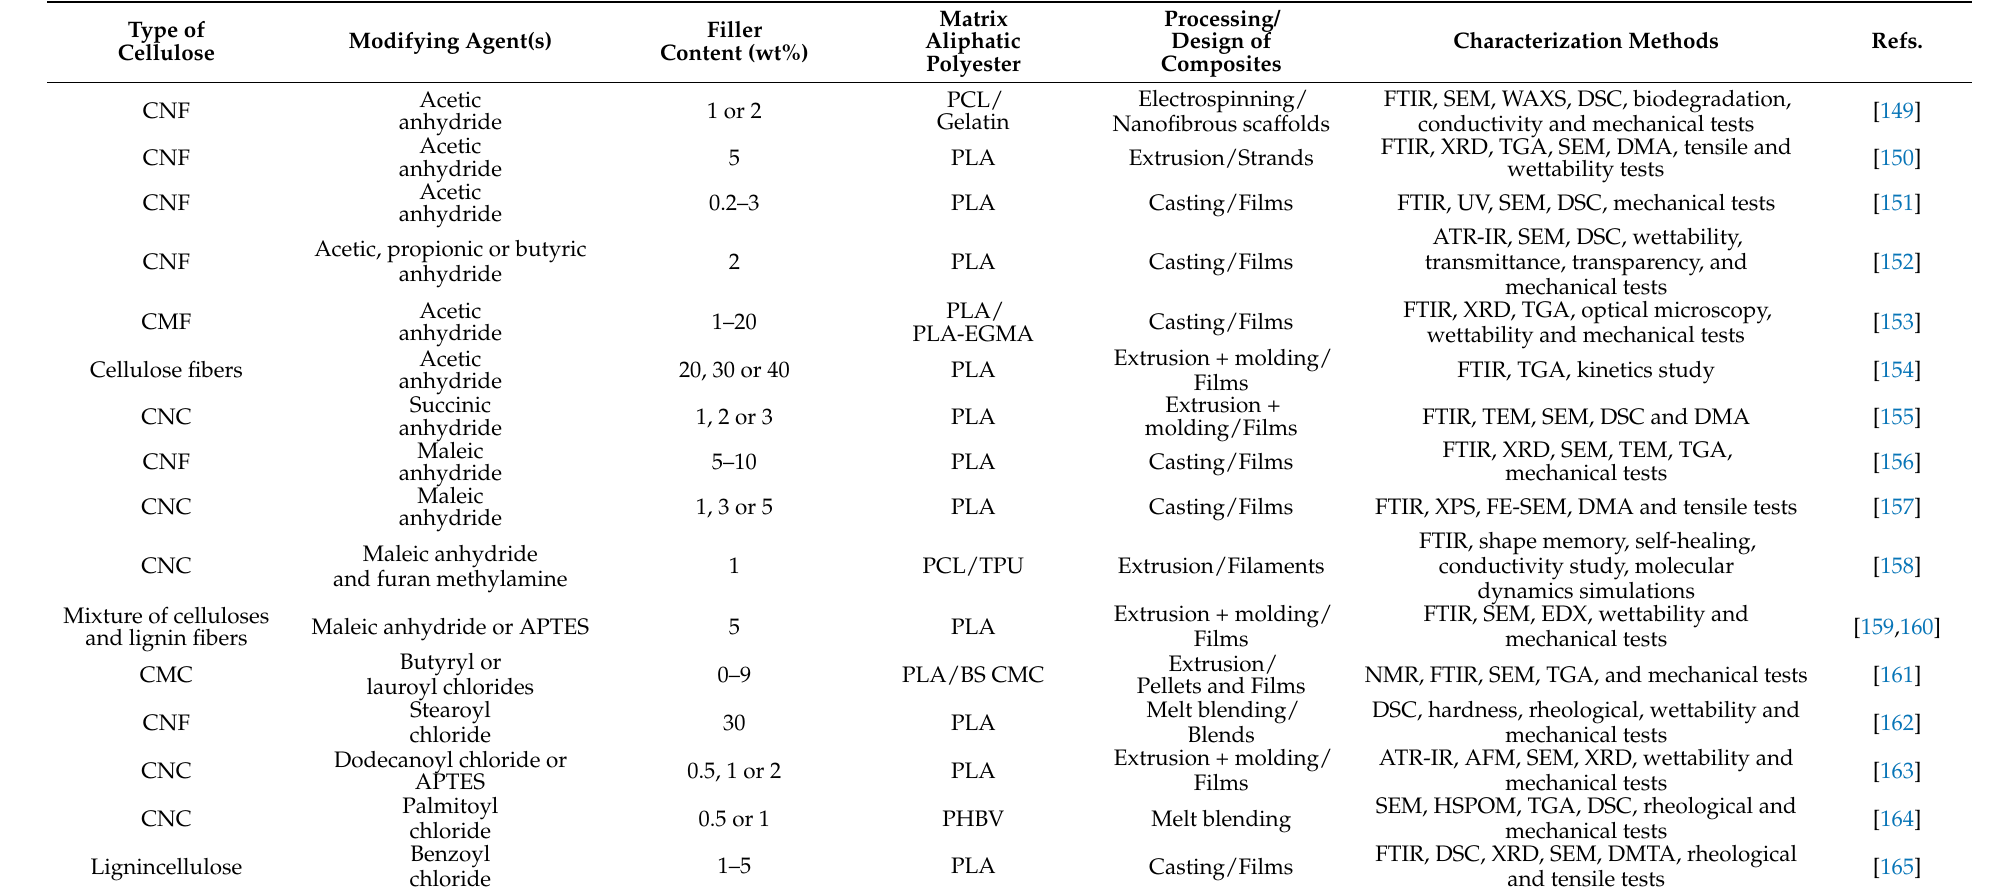
Table 5. Summary on covalent modification of cellulose micro- and nanomaterials via acylation with anhydrides of carboxylic acids and acyl chlorides for the preparation of composites with aliphatic